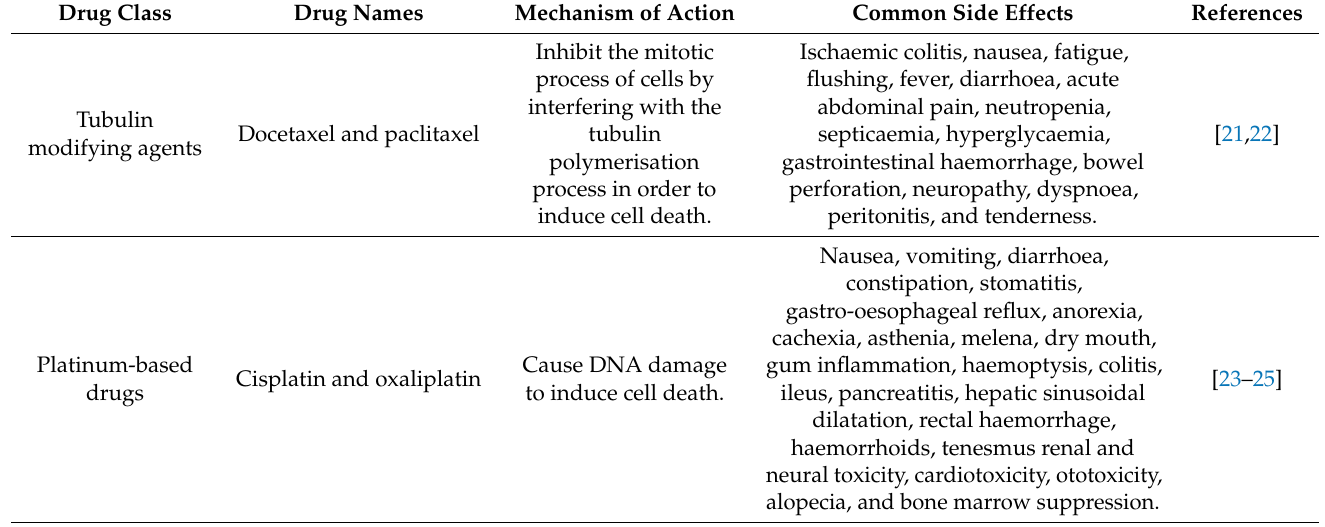
Table 1. Classes of chemotherapy drugs, drug names, their mechanisms of action, and their common side effects, with